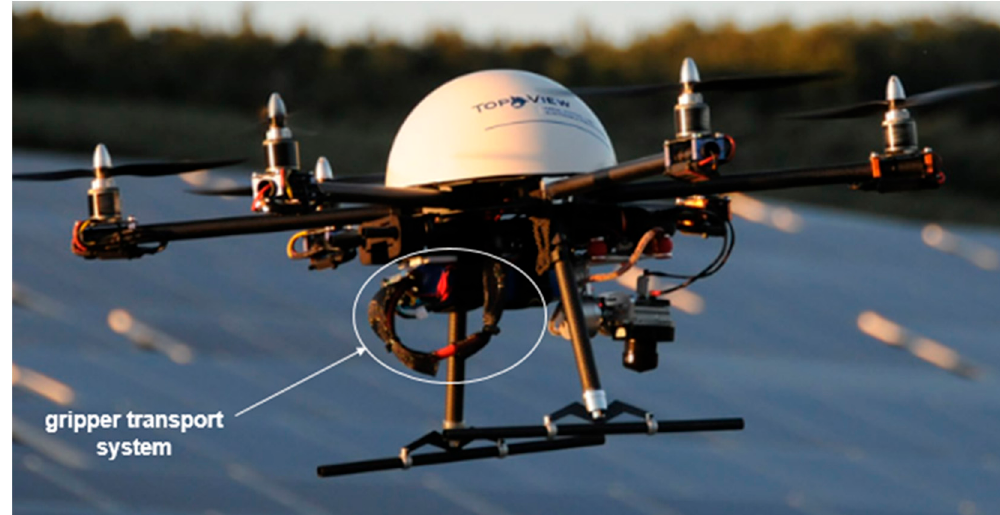
Figure 3. Illustration of the gripper transport system of the drone served to pick and release the sensor on the field.